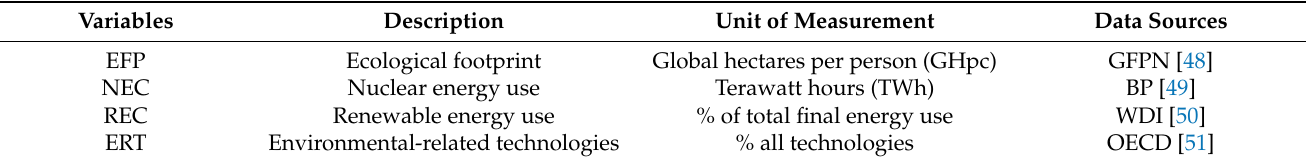
Table 2. Variable description, measuring unit, and data